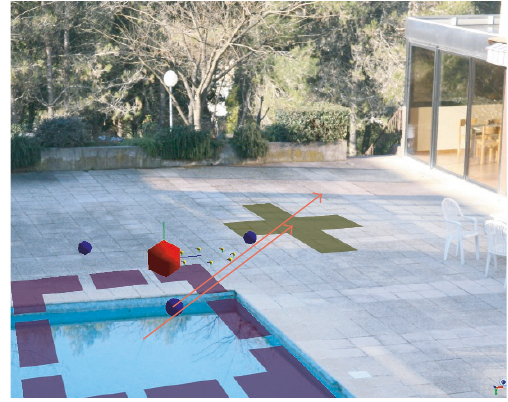
Figure 16: An example interface for source relocalization. In this example, we select the area corresponding to the fountain (in pur- ple) and translate it to a new location (shown as a yellow cross). The listener is depicted as a large red sphere, the microphone array as small yellow spheres, and the blue spheres show cluster